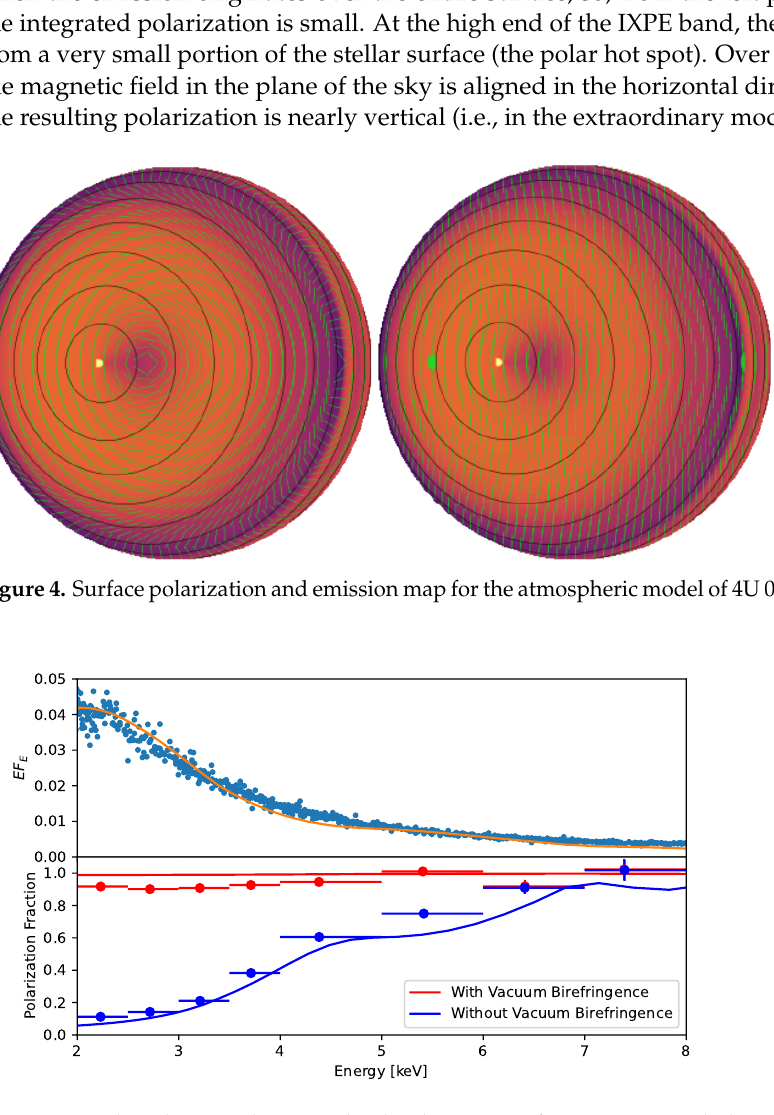
Figure 5. Predicted mean phase-resolved polarization of 4U 0142+61 and phase-averaged flux [39] from the atmospheric models of [14] with a simulated 1 Ms observation with